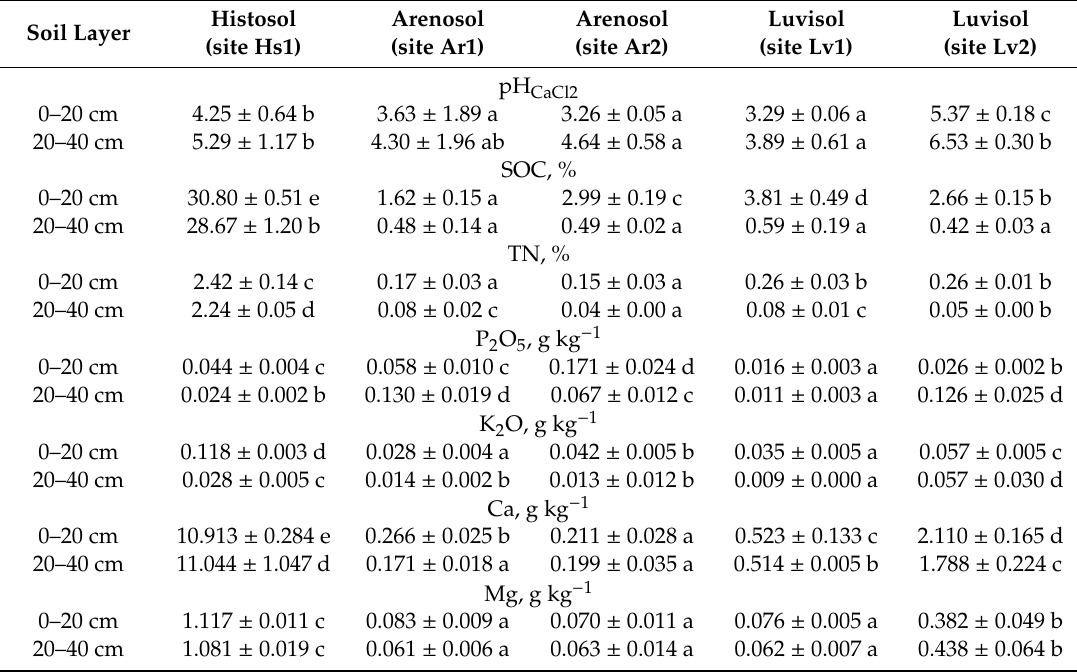
Table 2. Chemical properties of the mineral or peat top layers (0-20 and 20-40 cm depth) in the selected silver birch ( Betula pendula Roth) forest